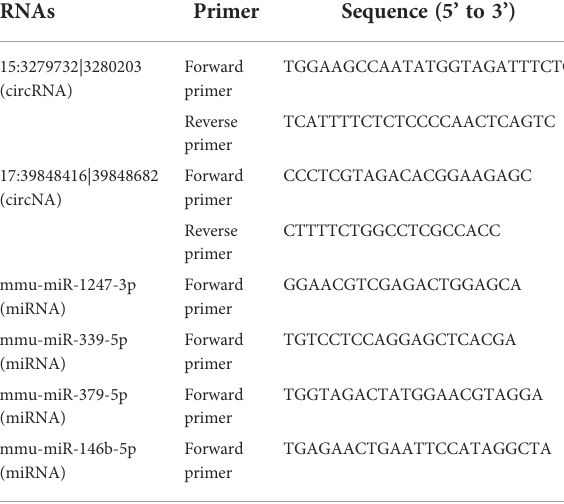
TABLE 1 Primers used in lncRNA and mRNA-speci fi c qRT-PCR analysis.